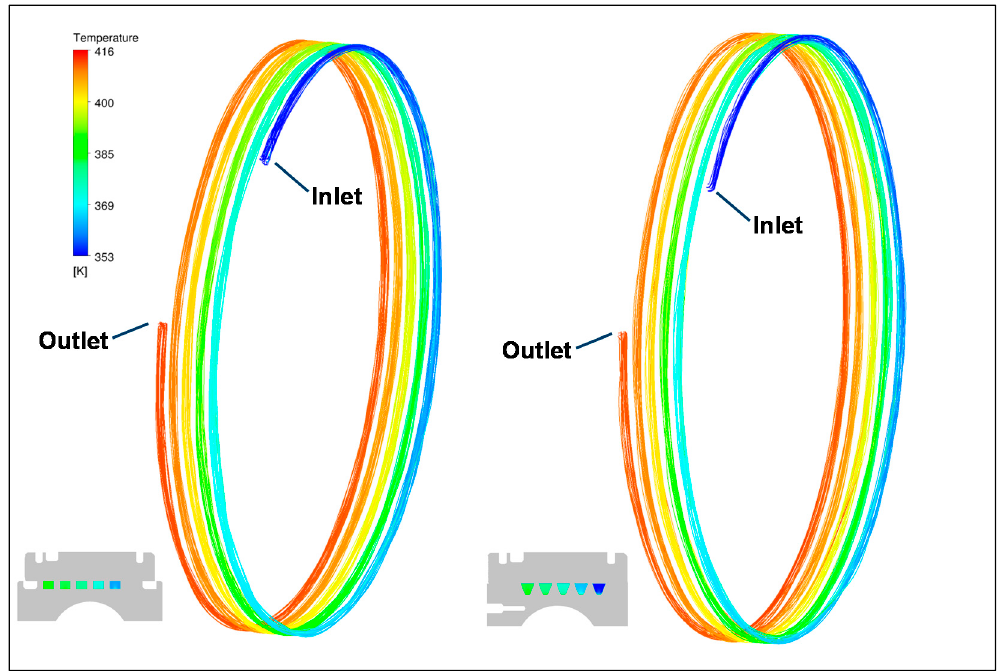
Figure 25. The temperature distribution in the fluid for the conventional and the V-type cross section. In the first two thirds of the length the rate of change of the fluid temperature is the highest.